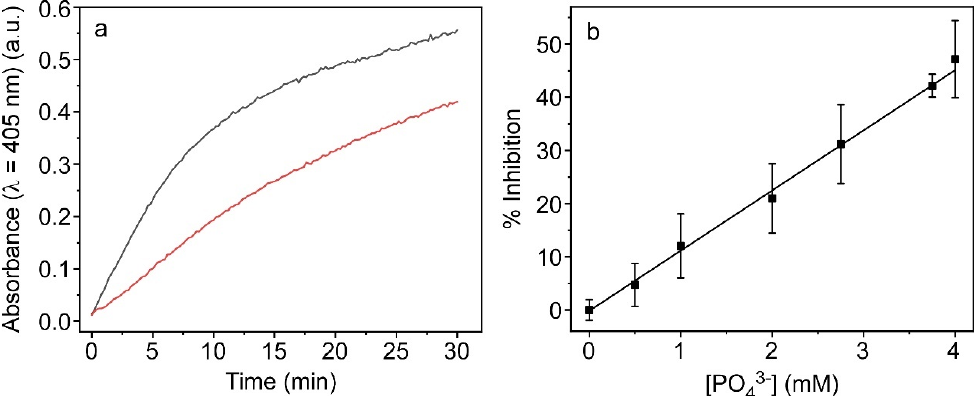
Figure 7. ( a ) PNP production kinetics measured in ALP@AETA after its immersion in a 50 µ M PNPP solution in the absence (black line) and presence (red line) of the phosphate ion inhibitor (4 mM). Samples were placed in quartz cuvettes of 1 cm path length and absorbance values were collected as function of time at 405 nm. ( b ) % Inhibition obtained for ALP@AETA in the absence and presence of different concentrations of phosphate ion after 10 min of incubation. Error bars stand for the standard deviation of three replicates.